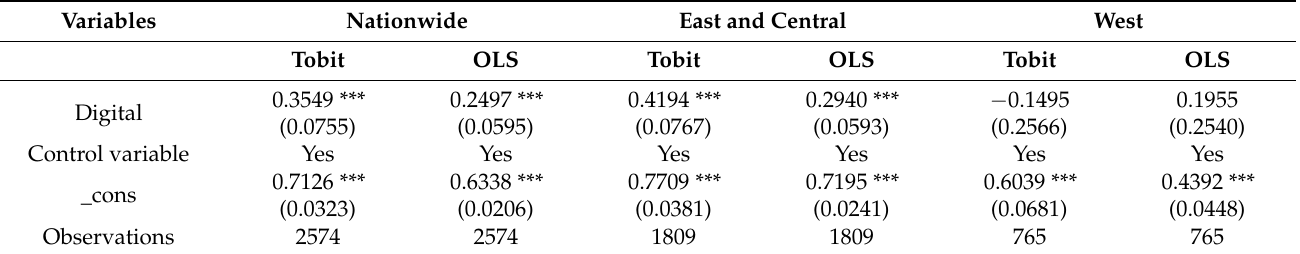
Table 2. Regression